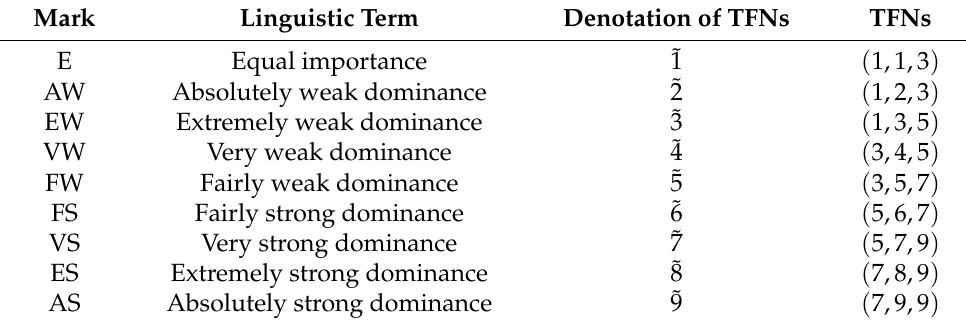
Table 1. Marks, linguistic terms, and denotation of